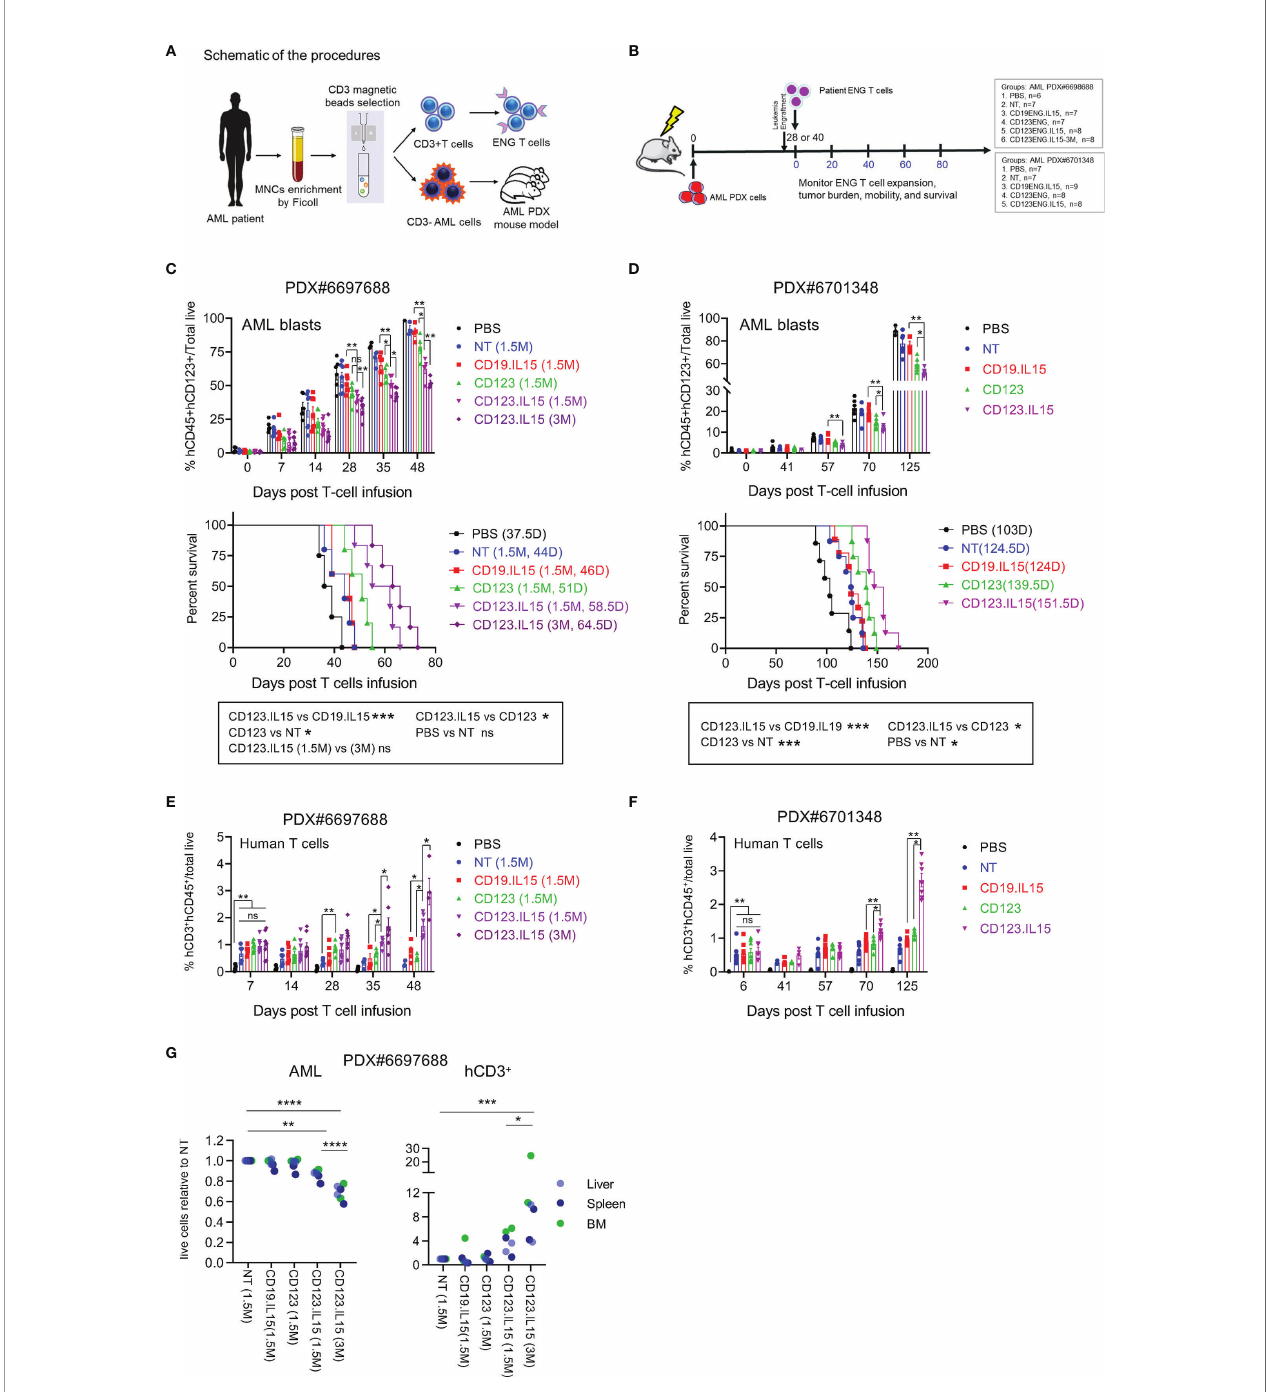
FIGURE 4 | Autologous CD123-ENG.IL15 T-cells have improved persistence and anti-leukemia activity in AML PDX mouse models. (A) Schema of generation matching CD123-ENG.IL15 T-cells and AML PDX mouse model. (B) Schema of AML PDX#6698688 and PDX#6701348 animal experiments. (C) PDX#6698688 AML PDX model: Circulating hCD45 + hCD123 + mCD45 − AML PDX cells (top panel) and Kaplan – Meier survival analysis (bottom panel). (D) PDX#6701348 AML PDX model: Circulating hCD45 + hCD123 + mCD45 − AML PDX cells (top panel) and Kaplan – Meier survival analysis (bottom panel). Statistical analysis for in (C, D) data are shown as mean ± SE, ***p <0.001, **p <0.01, *p <0.05, ns: not signi fi cant, top panels: t -test; bottom panels: two-tailed log-rank Mantel – Cox tests. (E, F) Circulating hCD45 + hCD3 + mCD45 − T- cells of total live cells of mouse PB in (E) PDX#6698688 and (F) PDX#6701348 model; data are shown as mean ± SE, **p <0.01, *p <0.05, ns, not signi fi cant, t -test. (G) On day 28 post infusion two mice per group of PDX#6698688 model were euthanized and the frequency of human AML and T cells were determined. Relative frequency of human AML and T cells in analyzed tissues is shown, ****: p <0.0001, ***p <0.001, **p <0.01, *p <0.05, two-way